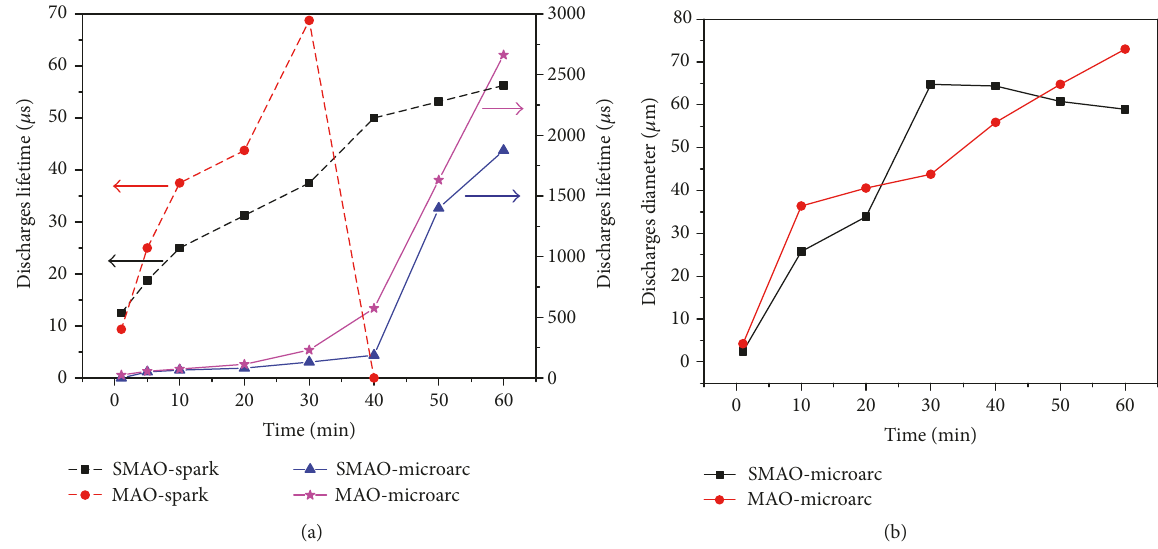
Figure 3: MAO and SMAO (a) discharge life time-treatment time curves and (b) discharge diameter-treatment time curves for conventional and SMAO processing.